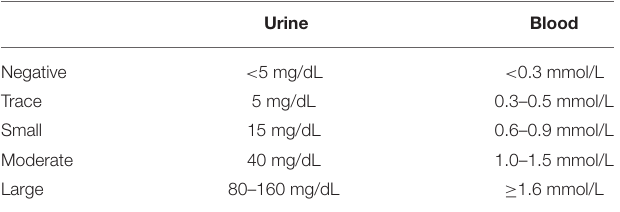
TABLE 11 | Measurement of ketosis with urine and blood ketone